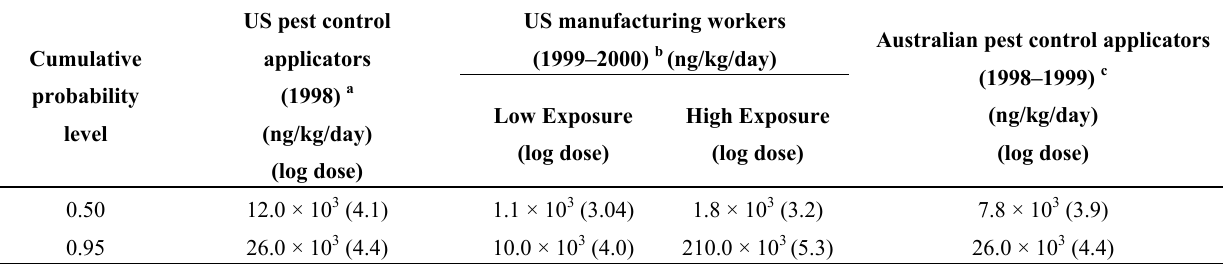
Table 4. Equivalent chlorpyrifos ingested doses (ECID) in pest control applicators and manufacturing workers in Australia and